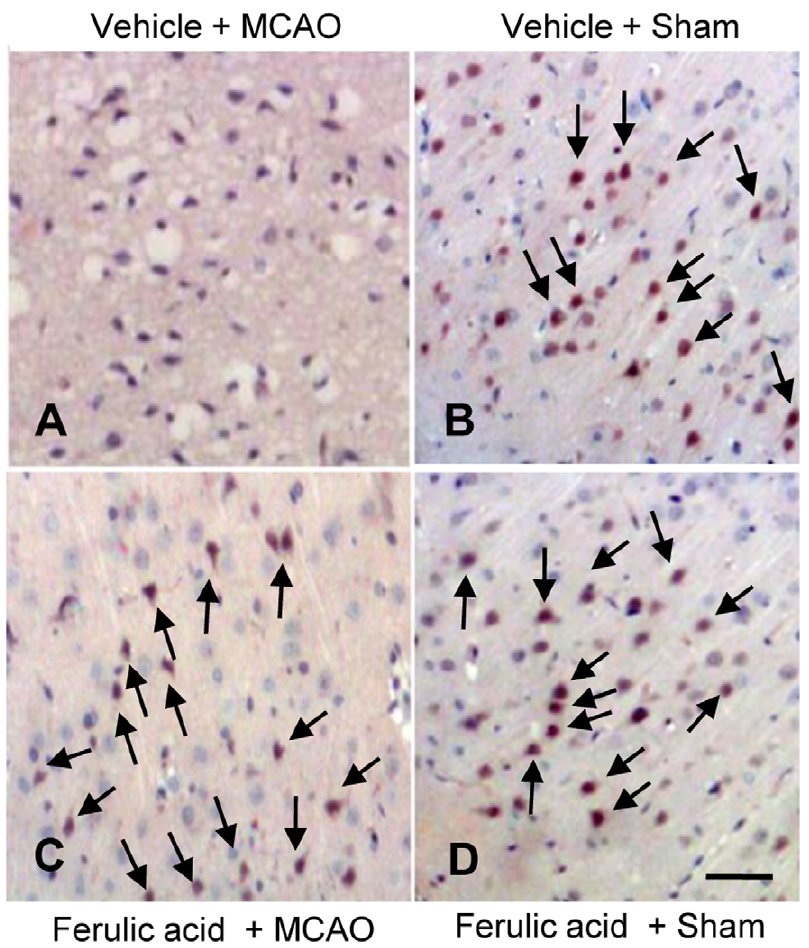
Figure 5. The expression of protein phosphatase 2A (PP2A) subunit B protein by ferulic acid in focal cerebral ischemia. Immuno- staining of protein phosphatase 2A (PP2A) subunit B in the cerebral cortices from vehicle + MCAO, ferulic acid + MCAO, vehicle + sham, ferulic acid + sham animals. Animals were treated with vehicle or ferulic acid prior to MCAO. Arrows indicate positive cells of PP2A subunit B. Scale bar=100 m m.